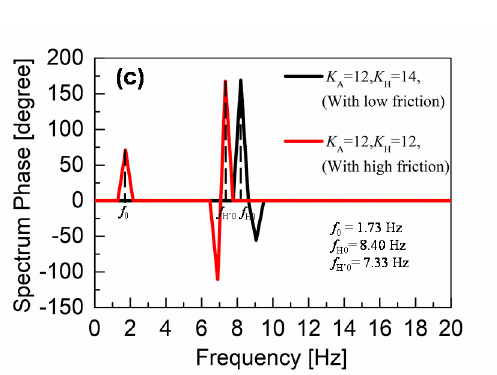
Figure 14. ( a ) Shows that robots can walk on a surface of φ = 9.7 ◦ inclination with K H = 12, when the robot-feet friction is increased. ( b ) Illustrates two important features, which result from the increased-friction-enabled K H lowering: First, lowering of the frequency, induced by the additional hip-pitch motor control, from 8.40 to 7.33 Hz. Second, reappearance of the peak at a fundamental walking frequency f 0 = 1.73 Hz. ( c ) The corresponding phase plot, which supports the appearance of the peak at f 0 and the lowering of K H . A tolerance value of 33% of the absolute maximum in the amplitude spectrum is used for the phase-plot calculation.